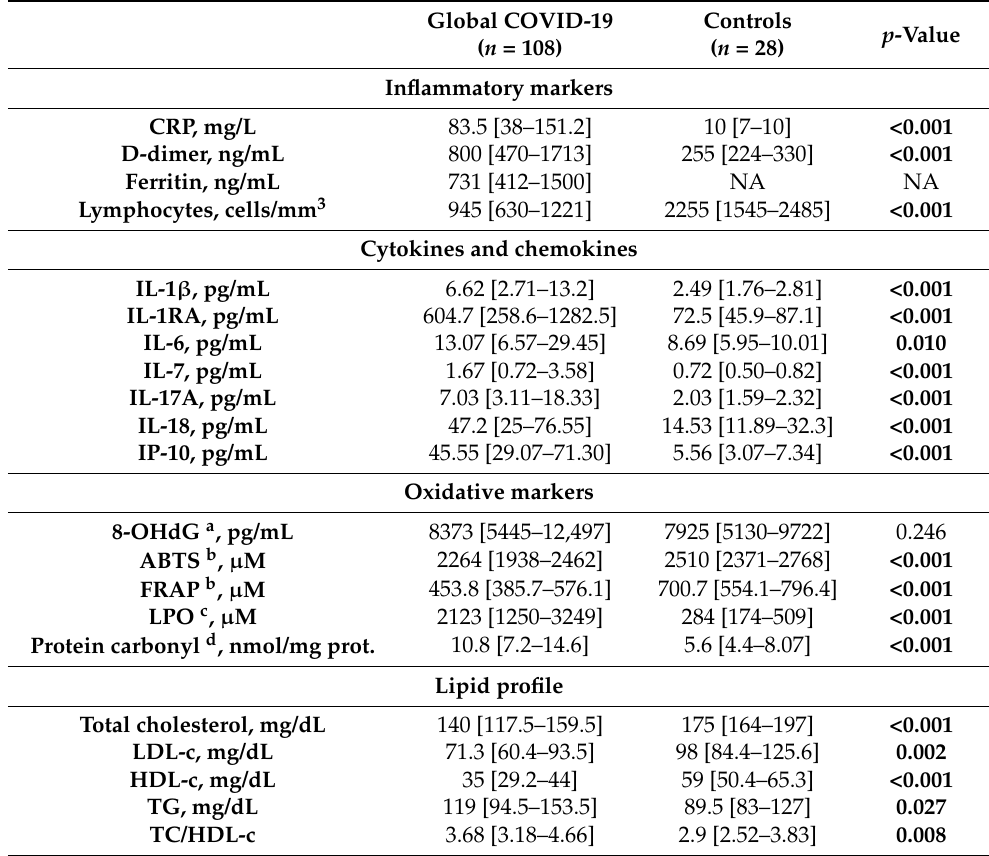
Table 1. Lipid, inflammatory, and oxidative stress profiles in COVID-19 patients vs. healthy controls at the time of hospital